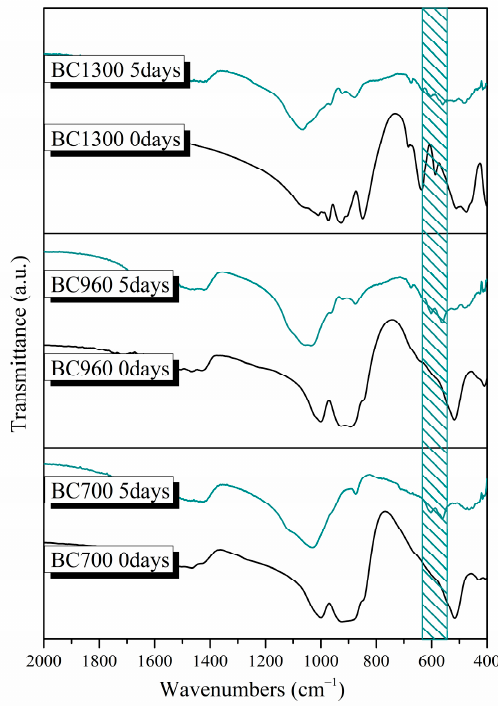
Figure 10. FTIR spectra of the bioceramic powders after 5 days of immersion in SBF. The shadow area between 560 and 640 cm − 1 highlights the double peak attributed to the formation of an apatite layer on the surface of all samples.